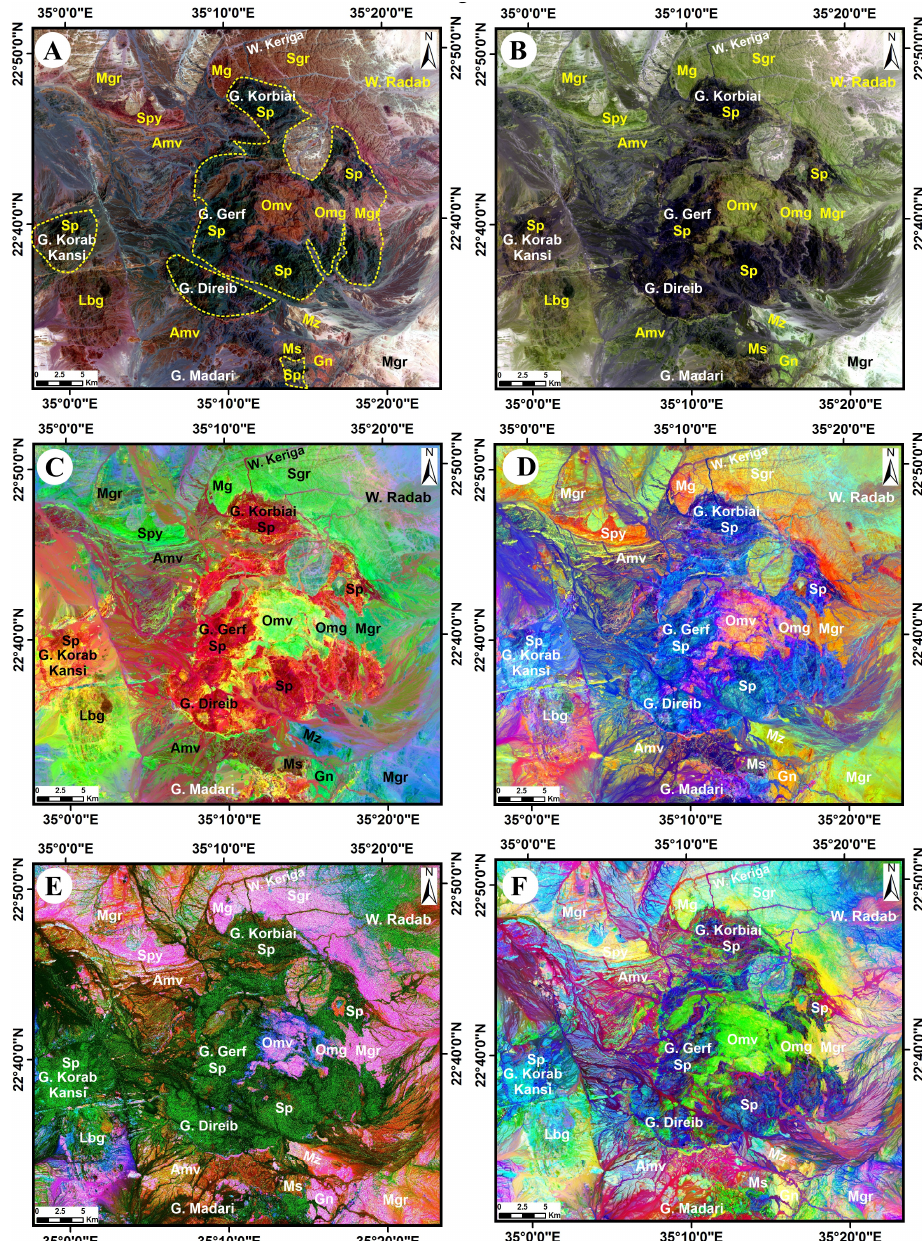
Figure 5. Lithological discrimination ( A ) FCC RGB-753 of landsat-8; ( B ) RGB-11 12 8 of Sentineal-2B; ( C ) band ratio of Chica–Olma (6/7, 6/5, 4/2 in RGB) of Landsat-8; ( D ) band ratio Kaufmann (7/5, 5/4, 6/7 in RGB) of Landsat-8 data; ( E ) Band ratio of 12/11 8/6 12/6 in RGB of Sentinel-2B and ( F ) PCA-432 in RGB for Landsat-8. The yellow dashed line in ( A ) outlined the ophiolite